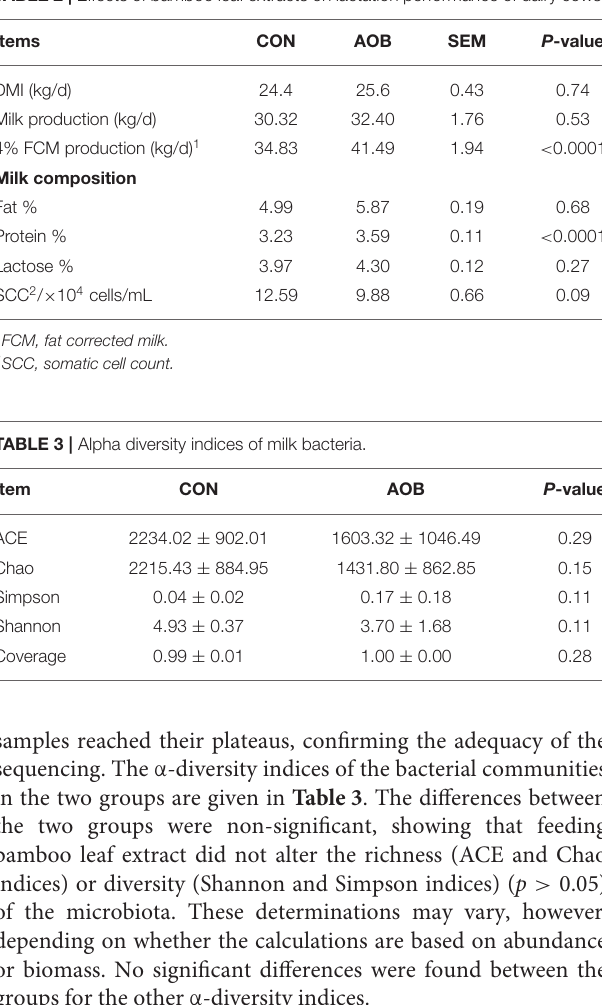
TABLE 2 | Effects of bamboo leaf extracts on lactation performance of dairy cows.